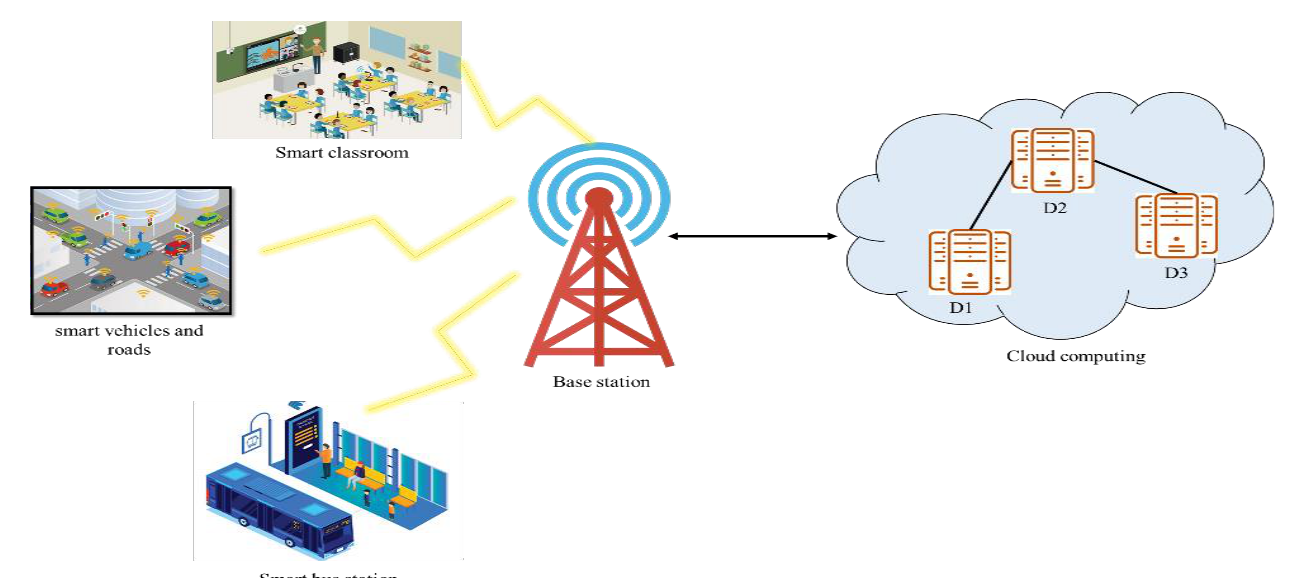
Figure 1. Data collection and storage in smart cities.